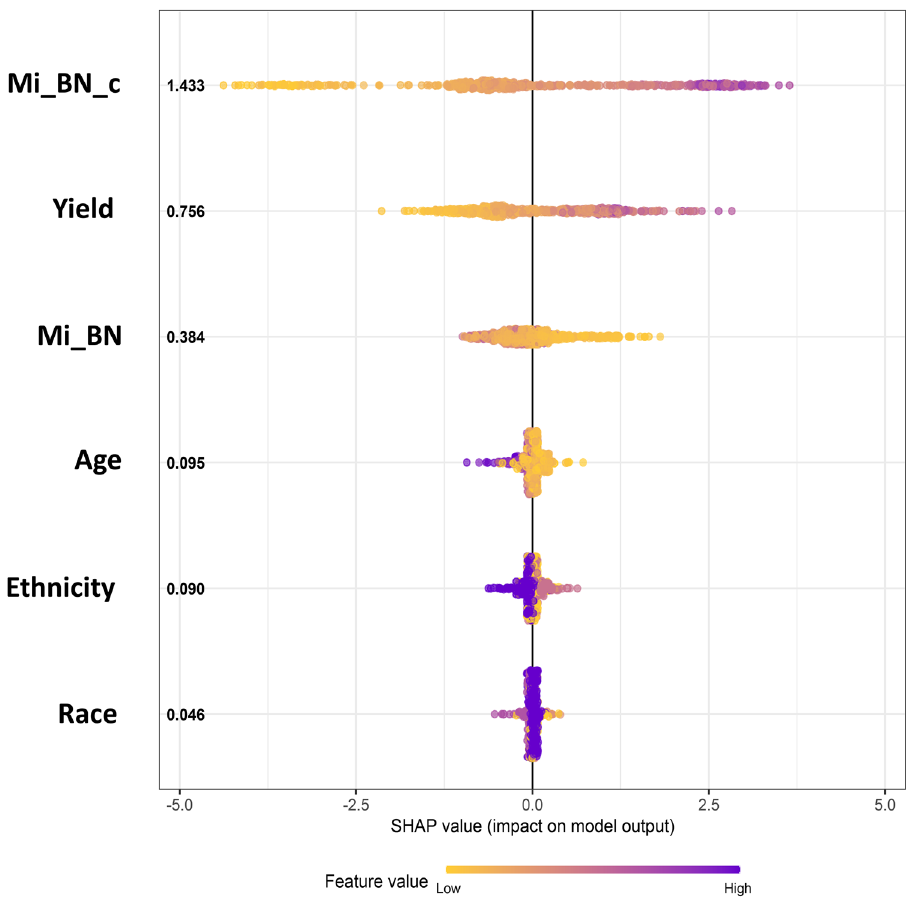
Figure 5. Visualization of how each predictor variable in the random forest model affected the model’s predictions (dose reconstructions). The SHAP metric, explained in the main text, was used to assess the importance of each predictor. Predictor variables (features) are listed on the left side in descending order, based on the mean absolute SHAP value (shown in bold black font). For example, corrected micronuclei yield (Mi_BN_c) was the predictor with the highest mean absolute SHAP value of 1.433 Gy. Negative SHAP values (left side of the figure) represent reductions in reconstructed dose, and positive ones (right side of the figure) represent increases in reconstructed dose. Each circle represents a blood sample (data point). Blue circles represent high feature values, and yellow ones represent low values. For example, high (blue) values of Mi_BN_c were associated with positive SHAP values, i.e. increased reconstructed dose, and low (yellow) values had the opposite effect. Details are discussed in the main